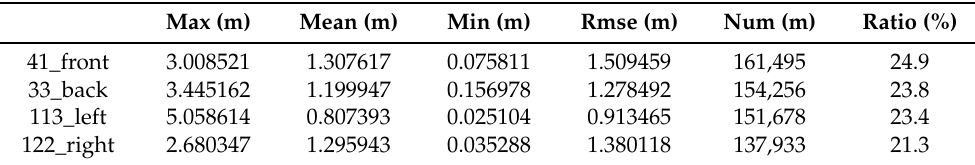
Table 3. Absolute trajectory error of critical values in four